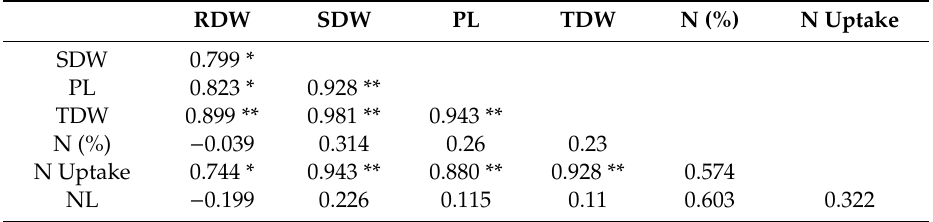
Table 7. Pearson’s correlation matrix between growth parameters of upland rice grown under greenhouse conditions 60 DAI. Plant length (PL), number of leaves (NL), root dry weight (RDW), shoot